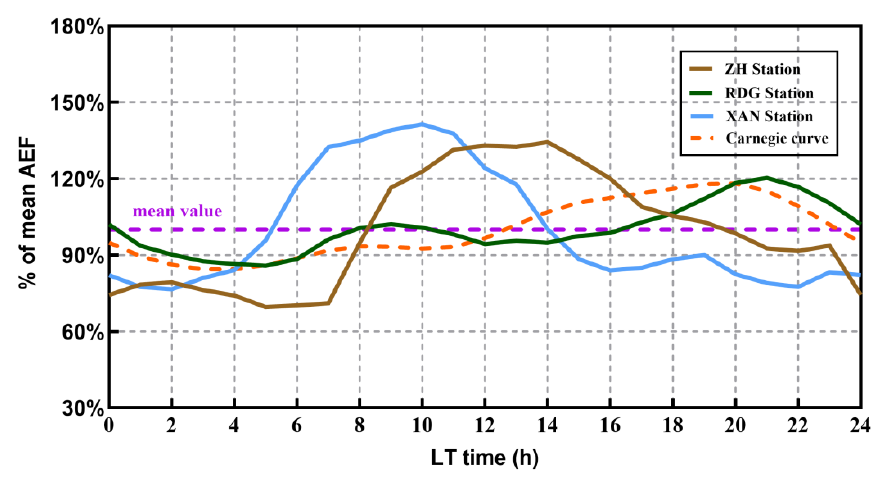
Figure 4. Average AEF daily variation on fair days at the RDG station, the ZH station, and the XAN station from 1 January to 31 December 2021 (the vertical coordinate is the percentage of atmospheric electric field/mean atmospheric electric field, and the brown curve indicates the percentage curve of average fair-weather AEF daily variation for the ZH station, the blue curve represents the XAN station, the green curve is the curve for the RDG station, and the orange curve is the Carnegie curve.).